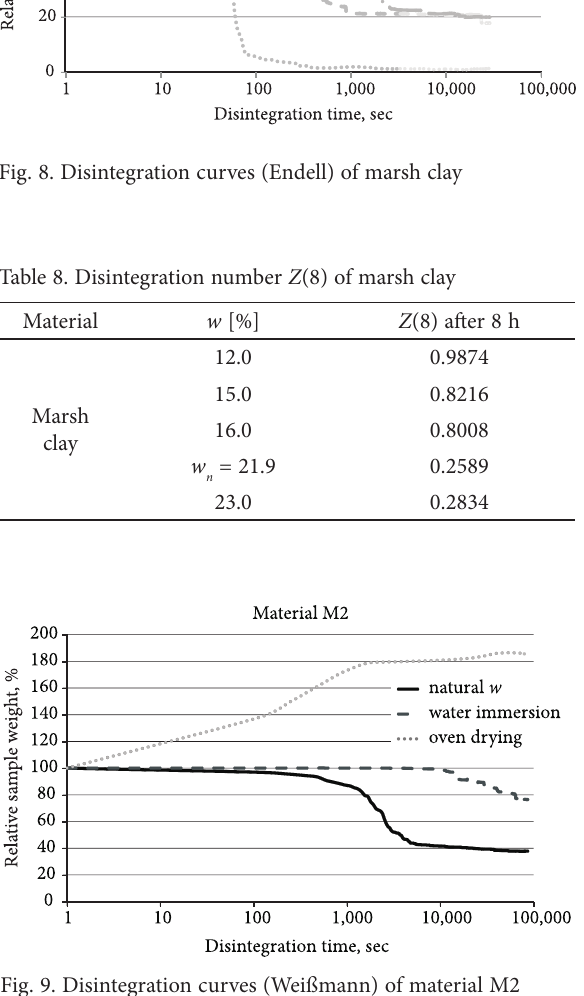
( w ) of M1, M2 and M3 30 n